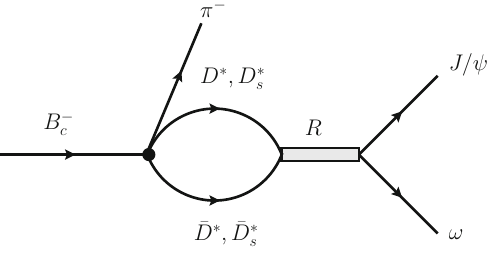
Fig. 2 Tree level contribution corresponding to the hadronization depicted in Fig. 1b